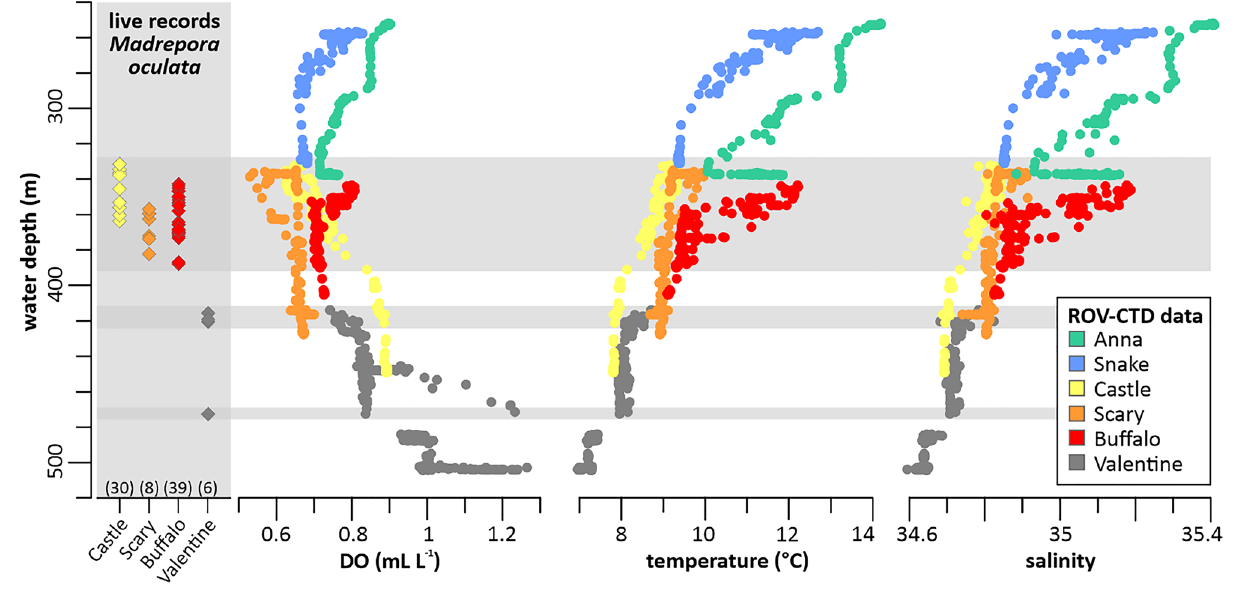
Figure 6. Depth distribution of Madrepora oculata and the corresponding environmental envelope off Angola. The water-mass properties (i.e. dissolved oxygen concentrations (DO), temperatures and salinities) were recorded with the ROV-mounted CTD during video surveys across various Angolan coral mounds (see legend for colour code; data for DO and temperatures were originally published in Hebbeln et al. 32 ). Live colonies of M. oculata (diamond symbols) were only observed on Castle (n = 30), Scary (n = 8), Buffalo (n = 39), and Valentine (n = 6) mounds. Depth levels of live M. oculata occurrences are highlighted by horizontal grey bars.